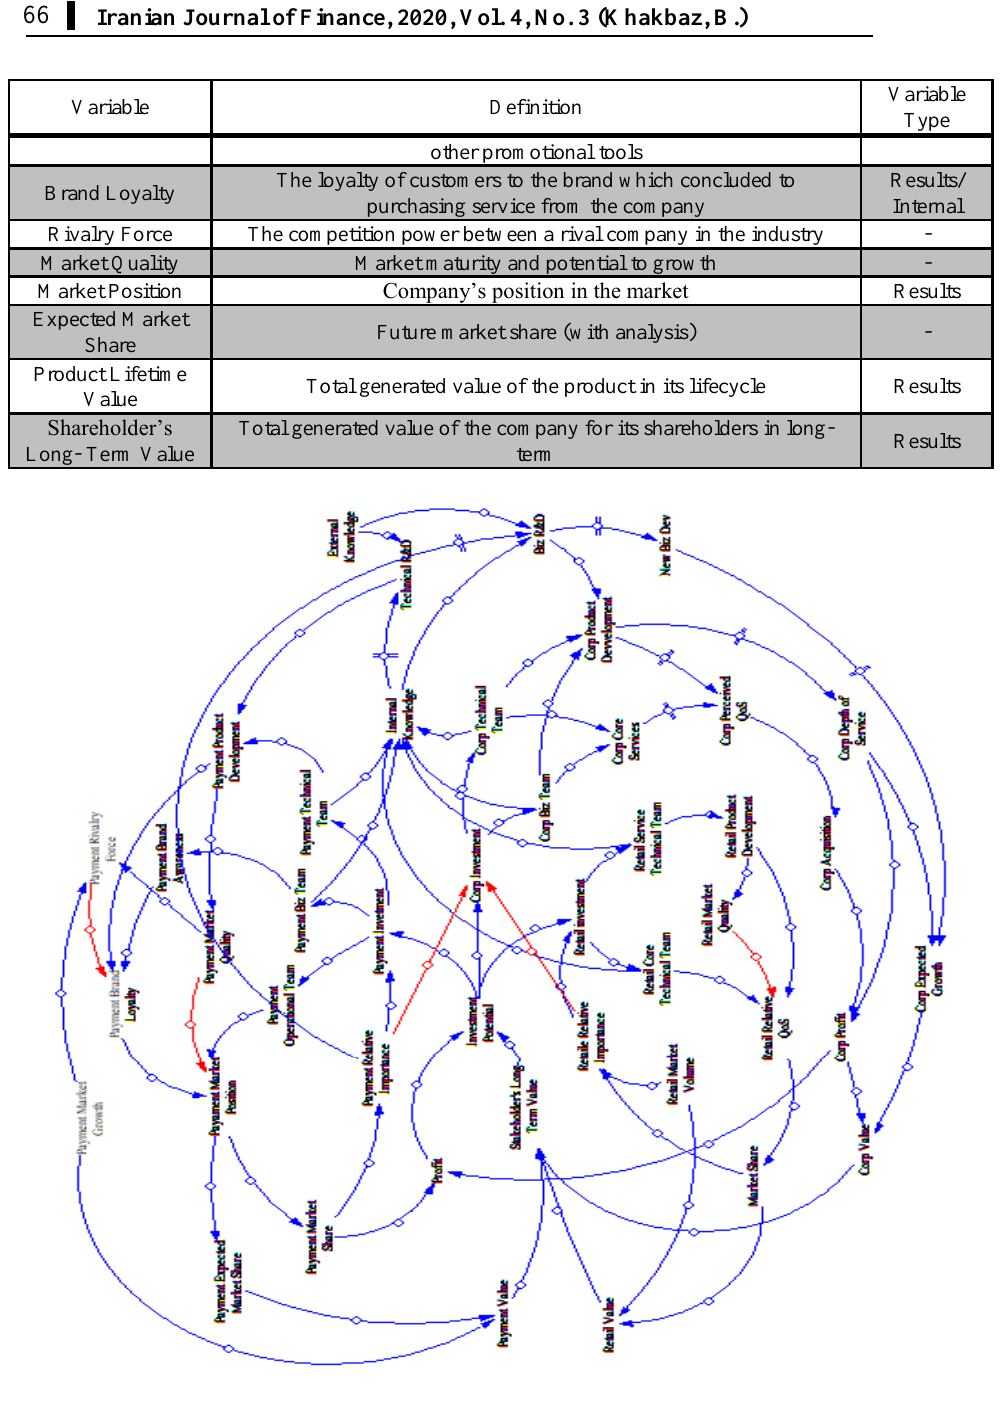
Figure 4. CLD for PPM model in financial technology ecosystem of